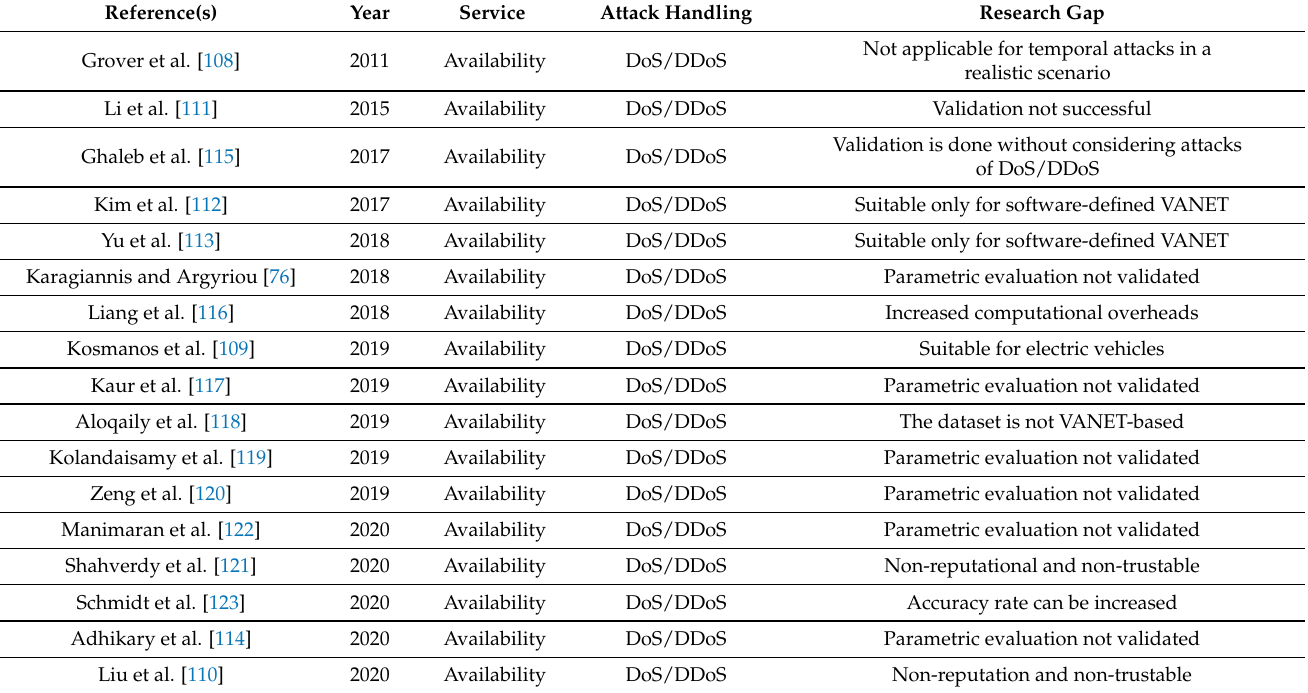
Table 7. List of machine learning and deep learning-based solutions for VANETs